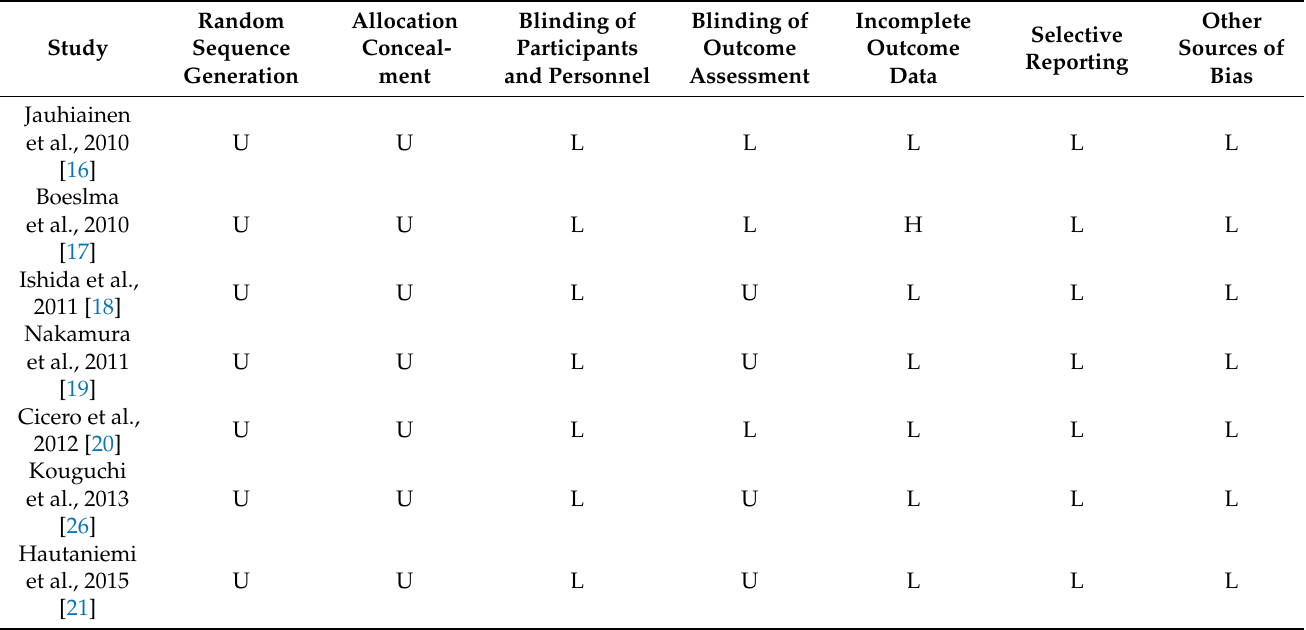
Table 3. Quality assessments of included studies based on the Cochrane